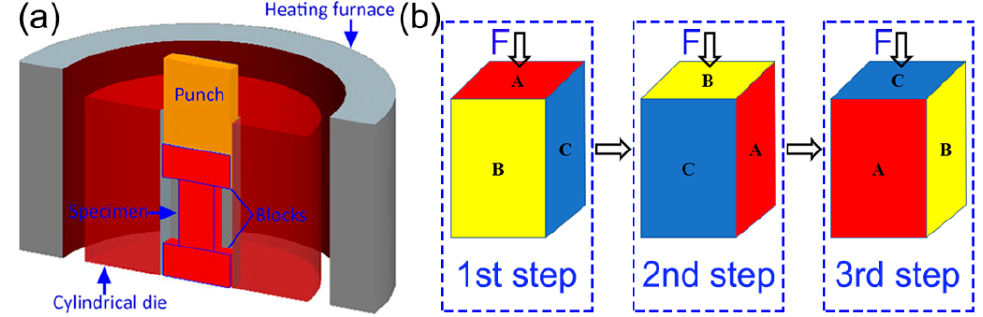
Figure 1. Schematic diagrams of the multi-directional forging (MDF) process: ( a ) equipment of MDF and ( b ) the sample processing routes during MDF.